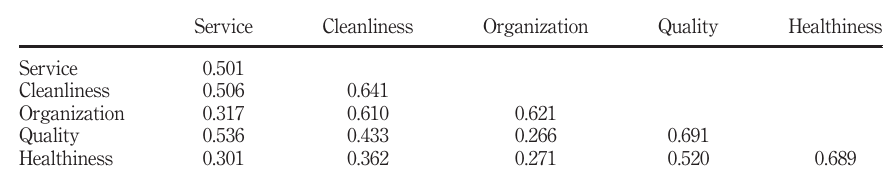
Table IV. Squared correlation between the latent variables and